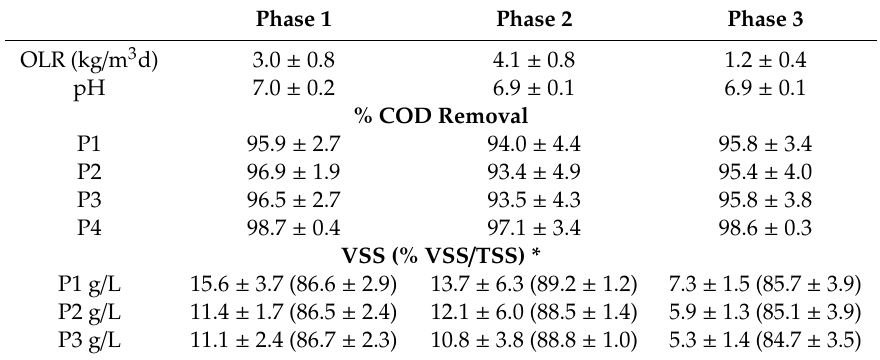
* Values in parentheses are the percentages of VSSs in